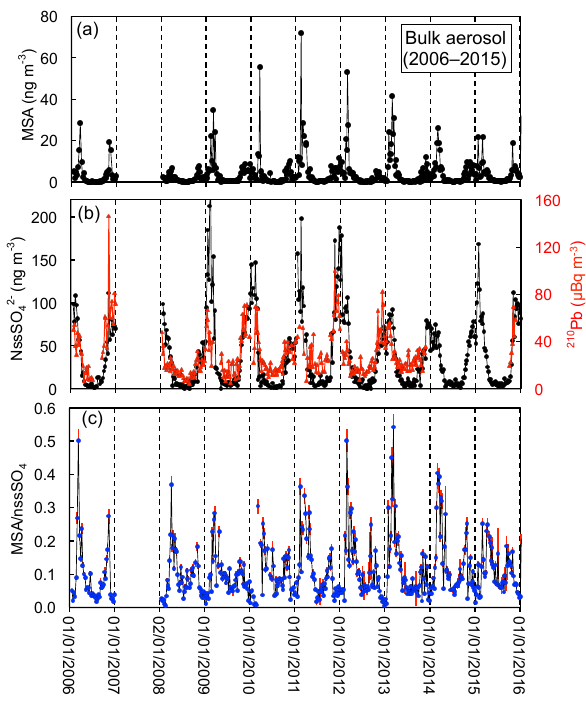
Figure 1. Weekly bulk aerosol concentrations of MSA (a) , nssSO 4 together with 210 Pb activities (b) , and the mass MSA / nssSO 4 ratio (c) . Vertical bars refer to uncertainty in calculating the MSA / nssSO 4 ratio (Eq. 3). Nine values of the MSA / nssSO 4 ratio were off-scale: August 2008 (1.1 ± 0.8), October 2008 (0.8 ± 0.1), May 2009 (0.7 ± 0.3), March 2010 (1.3 ± 0.1, 4.3 ± 0.4, and 1.7 ± 0.1), June 2010 (2.4 ± 1.3), September 2010 ( − 1 . 2 ± 2.2), and July 2012 (1.0 ±